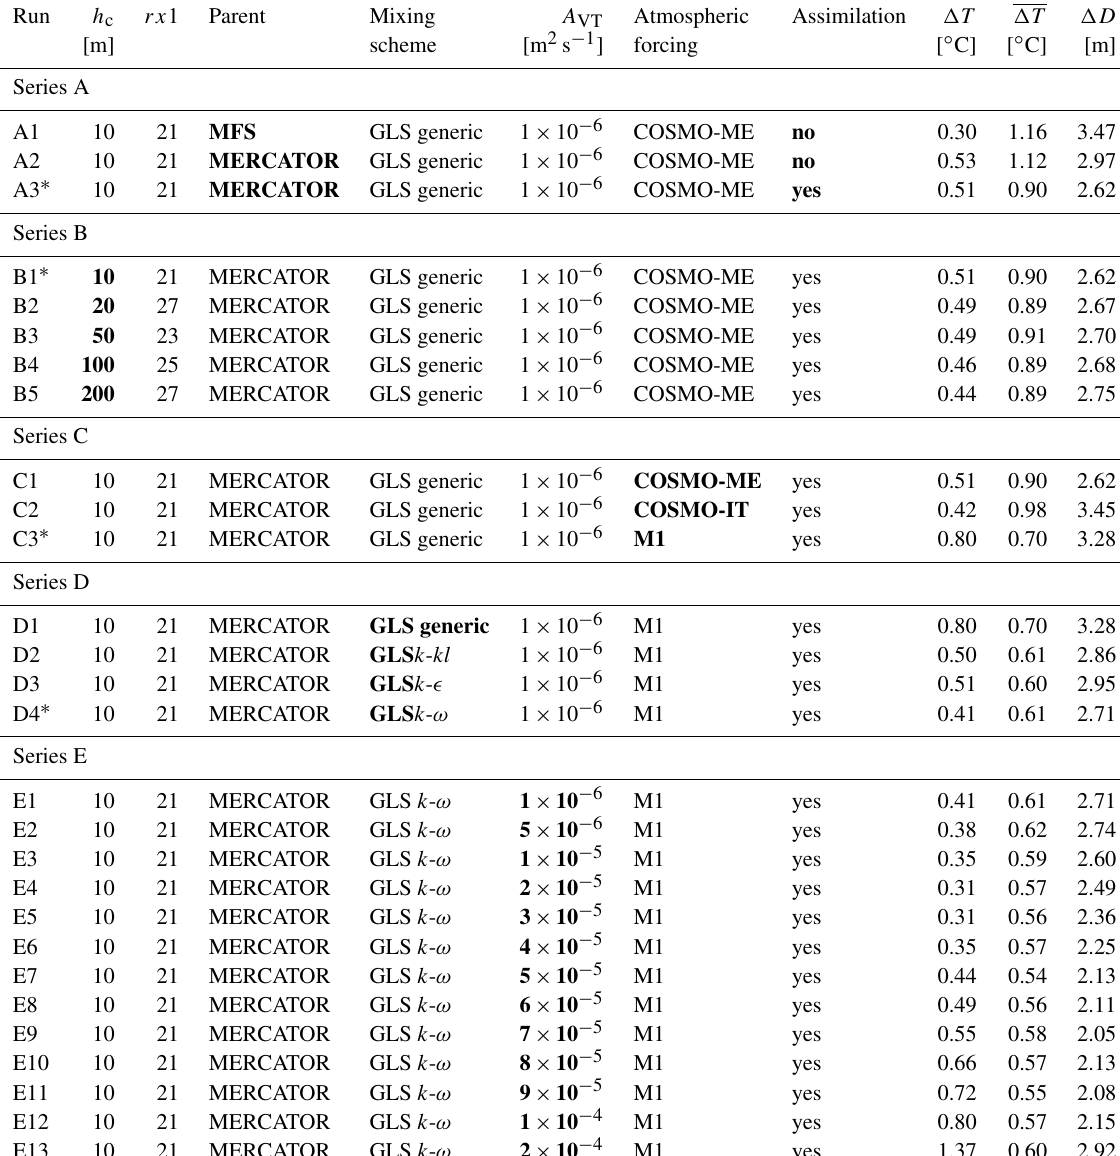
Table 2. The parameter settings and results of the ROMS runs in series A–E. The bold text indicates the parameters or boundary forcing patterns which are varied within the respective series. The best run in each series is marked by an asterisk and serves as the control run for the successive